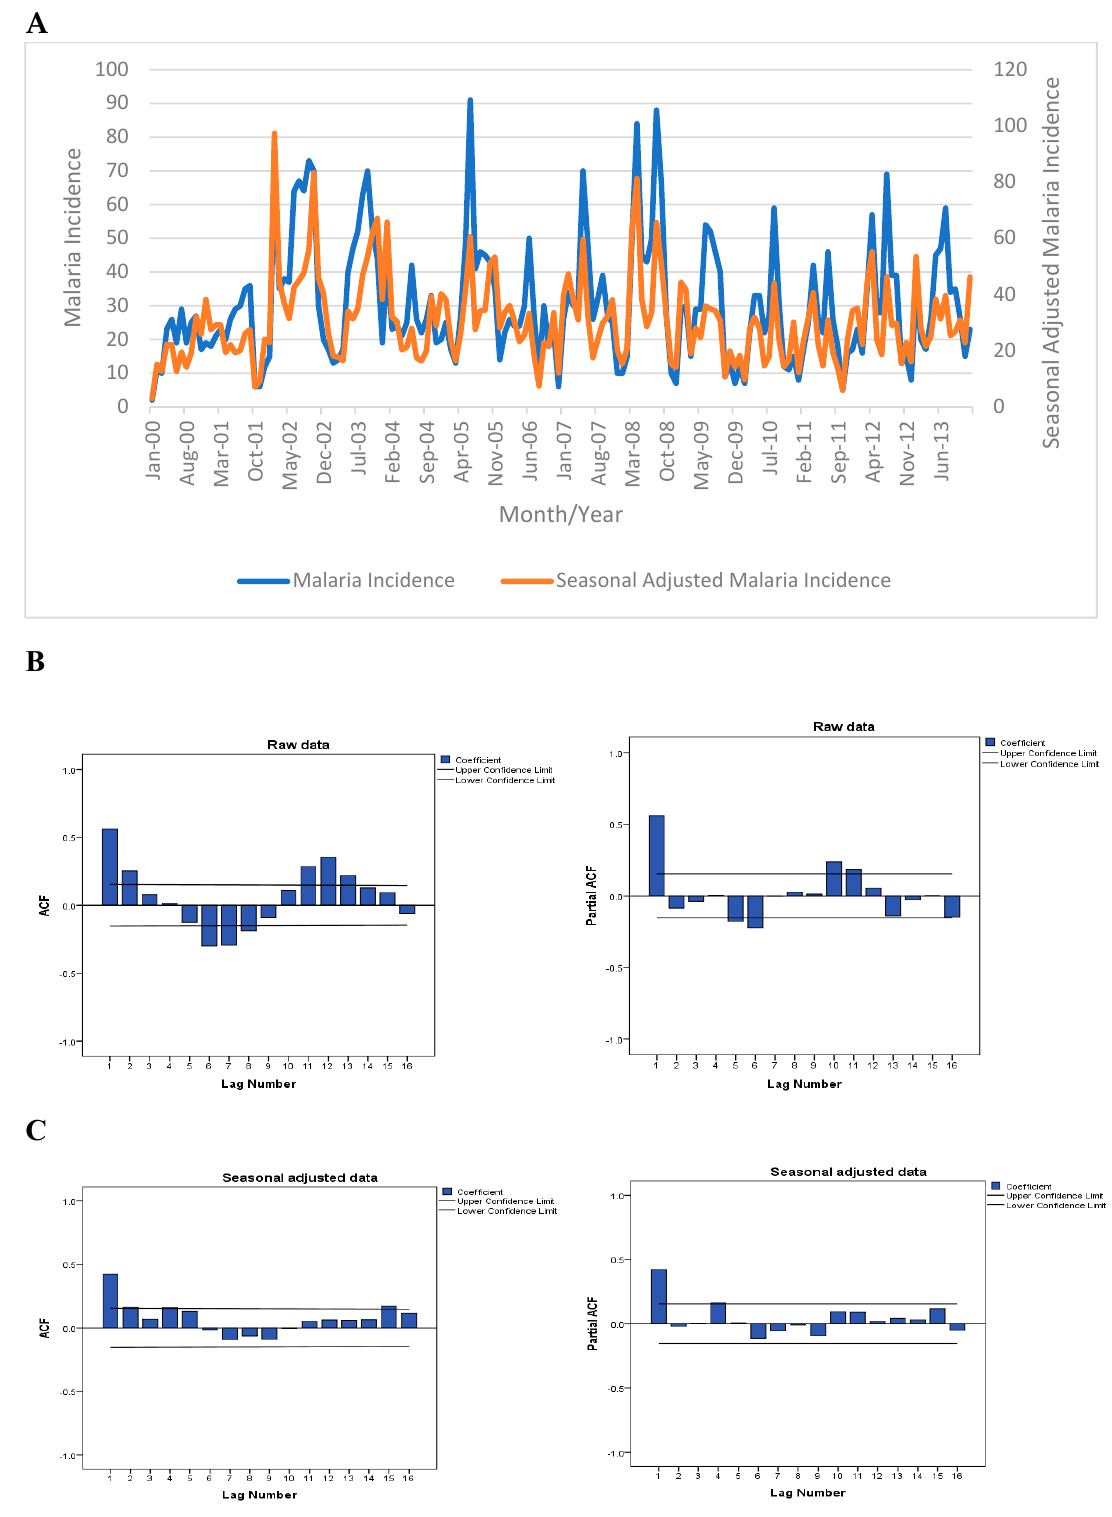
Figure 1. Malaria cases reported in the study area (2000–2013). ( A ) Malaria incidence: original and seasonally adjusted data (2000–2013); ( B ) Autocorrelation and partial autocorrelation functions computed from the raw data (cases); ( C) Autocorrelation and partial autocorrelation functions computed from the seasonally adjusted data.